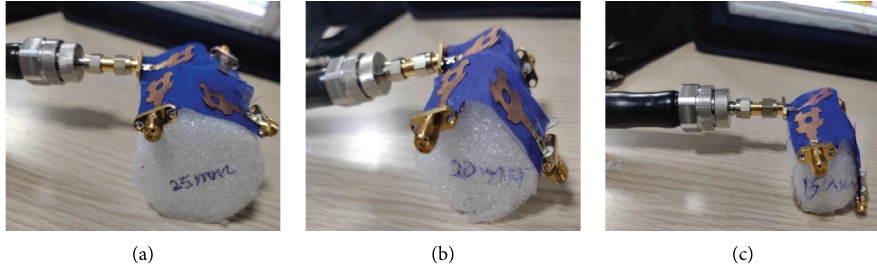
Figure 15: Bending analysis of the fabricated MIMO antenna: (a) r � 25mm, (b) r � 20mm, and (c) r �